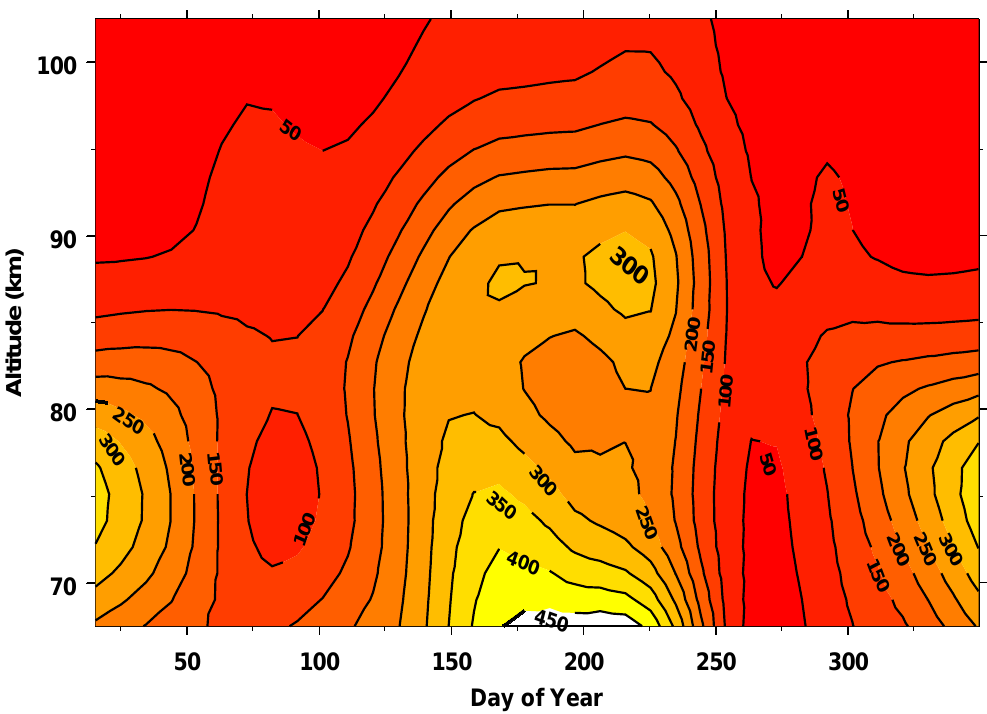
Fig. 4. The annual variation in the total turbulent diffusion at 70 ◦ S generated by gravity wave sources propagating upwards from 10km altitude. Contours are in units of m 2 s − 1